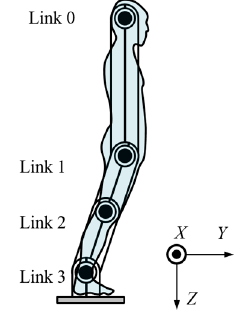
Figure 3. Rigid link model.